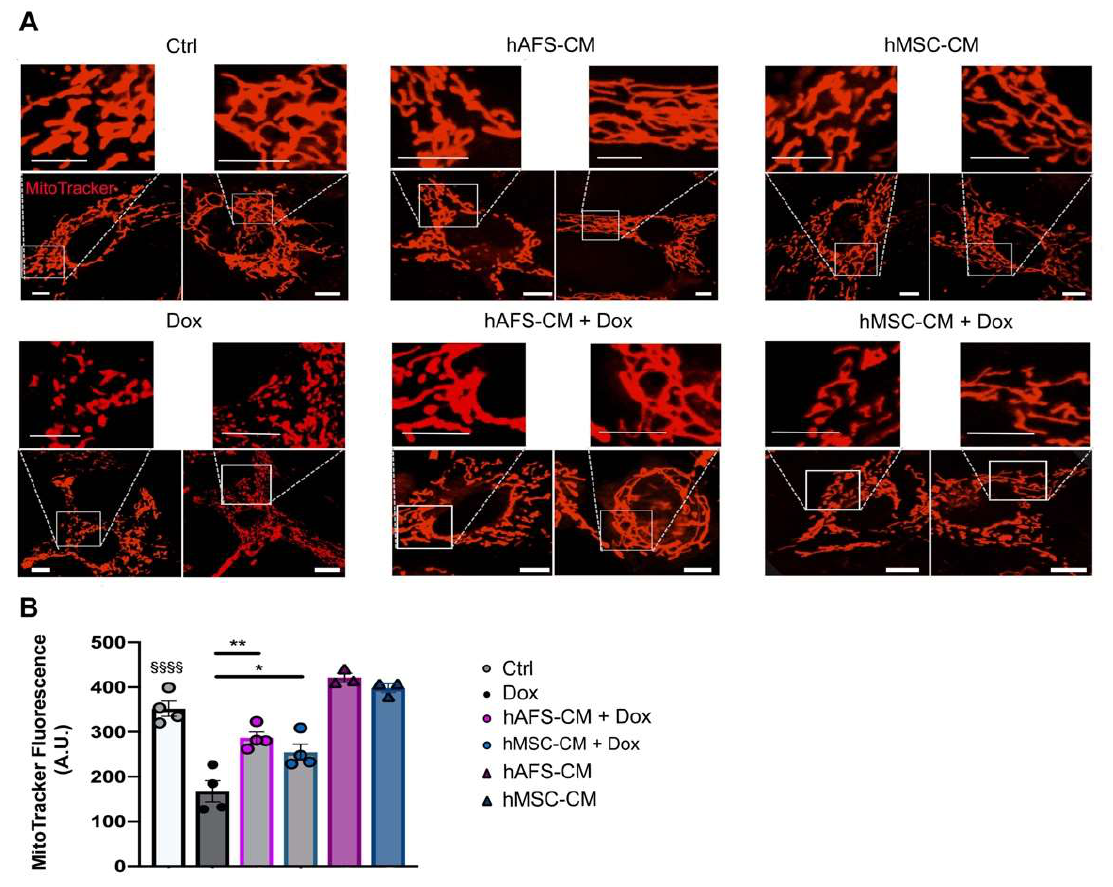
Figure 2. hAFS and hMSC secretomes preserve mitochondrial transmembrane potential in mNVCM exposed to Dox. ( A ) Representative confocal images of live mNVCM in control condition ( Ctrl ), undergoing stimulation with either hAFS-CM ( hAFS-CM ) or hMSC-CM ( hMSC-CM ) for 3 h or exposed to 1 µ M Dox for 16 h with or without ( Dox ) prior priming with hAFS-CM ( hAFS-CM + Dox ) or hMSC-CM ( hMSC-CM + Dox ) for 3 h. The cell mitochondrial network is represented in red by the MitoTracker signal, scale bar: 5 µ m, ( B ) Mitochondrial transmembrane potential evaluated by MitoTracker fluorescence analysis and expressed by arbitrary units ( A.U. ) mNVCM treated as follows: control condition ( n = 4, Ctrl: 351.85 ± 17.13 ); after exposure to 1 µ M Dox for 16 h ( n = 4, Dox: 167.52 ± 23.49 ); pretreated with hAFS-CM or hMSC-CM for 3 h before 1 µ M Dox stimulation for 16 h ( n = 4, hAFS-CM + Dox: 286.77 ± 12.94, and hMSC-CM + Dox: 254.57 ± 18.56 , respectively), or only pretreated with hAFS-CM or hMSC-CM ( n = 3, hAFS-CM: 421.63 ± 9.55 and hMSC-CM: 397.93 ± 9.57 , respectively). Values are expressed as the mean ± SEM of the independent experiments. hAFS-CM vs. Ctrl and hMSC-CM vs. Ctrl : not significant; Ctrl vs. Dox; §§§§ p < 0.0001; hAFS-CM + Dox vs. Dox ** p = 0.0012 ; hMSC-CM +Dox vs. Dox * p = 0.0185.